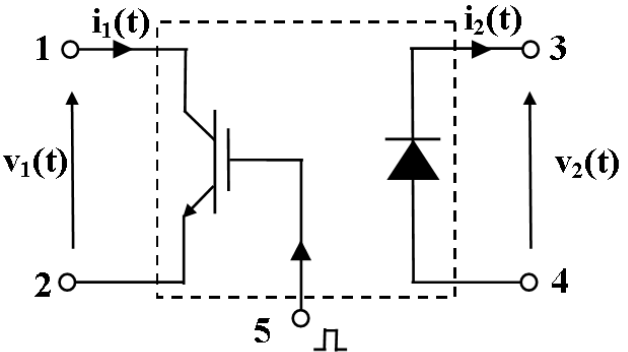
Figure 1. Diagram of a diode–transistor switch with IGBT and the diode.